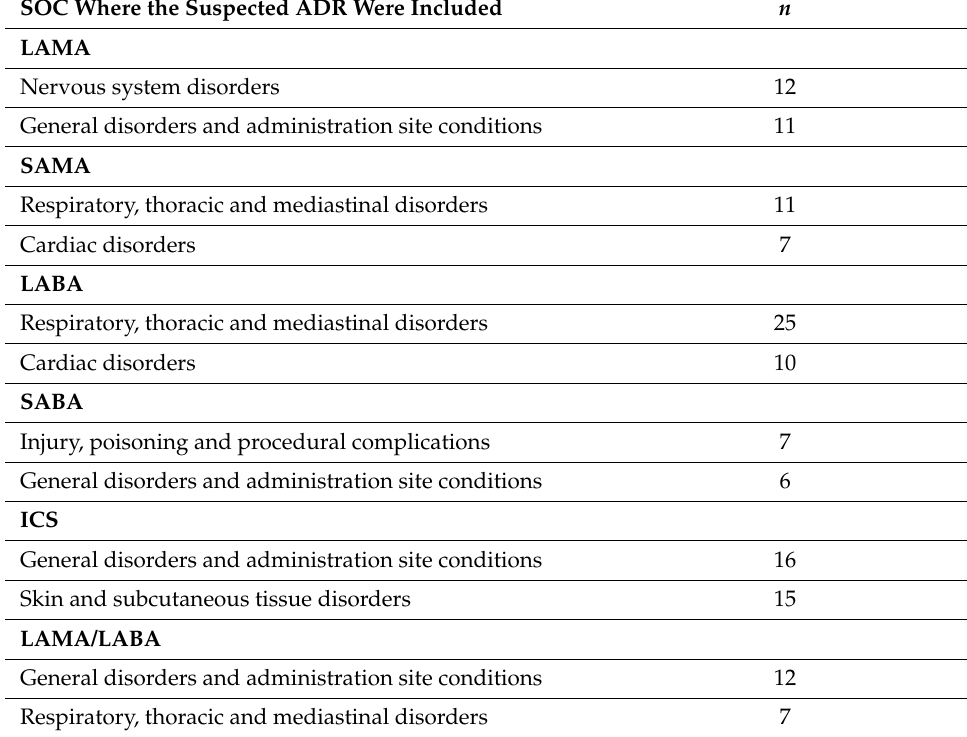
Table 6. Most frequently reported Adverse Drug Reactions (ADRs) according to System Organ Classes (SOC), by pharmacological